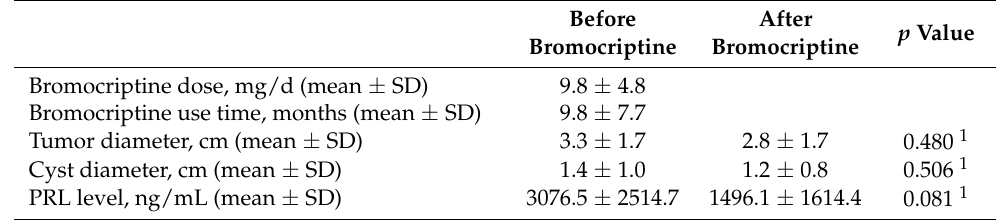
Table 4. The curative effect for 12 patients of operation treated regularly treated with bromocriptine.